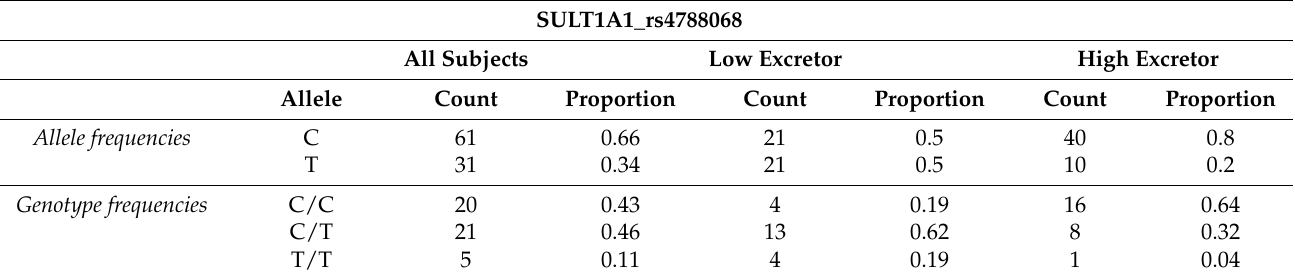
Table 7. Genotypes and allele frequencies of SULT1A1_rs4788068 polymorphism in studied population.